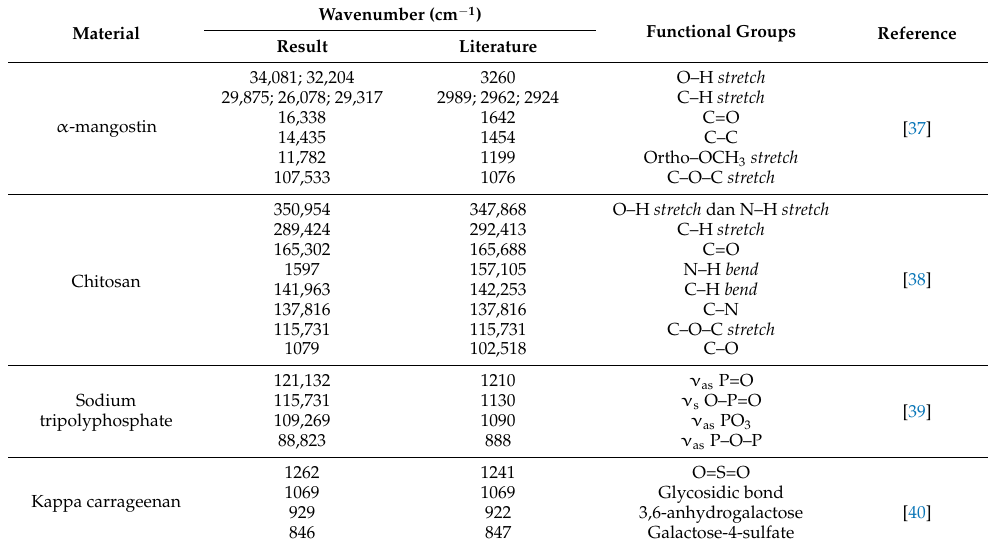
Table 3. FTIR wavenumber and corresponding functional